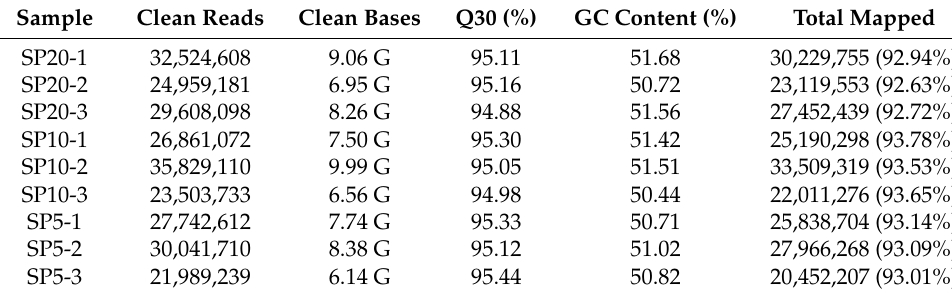
Table 4. Quality of transcriptome sequencing data.